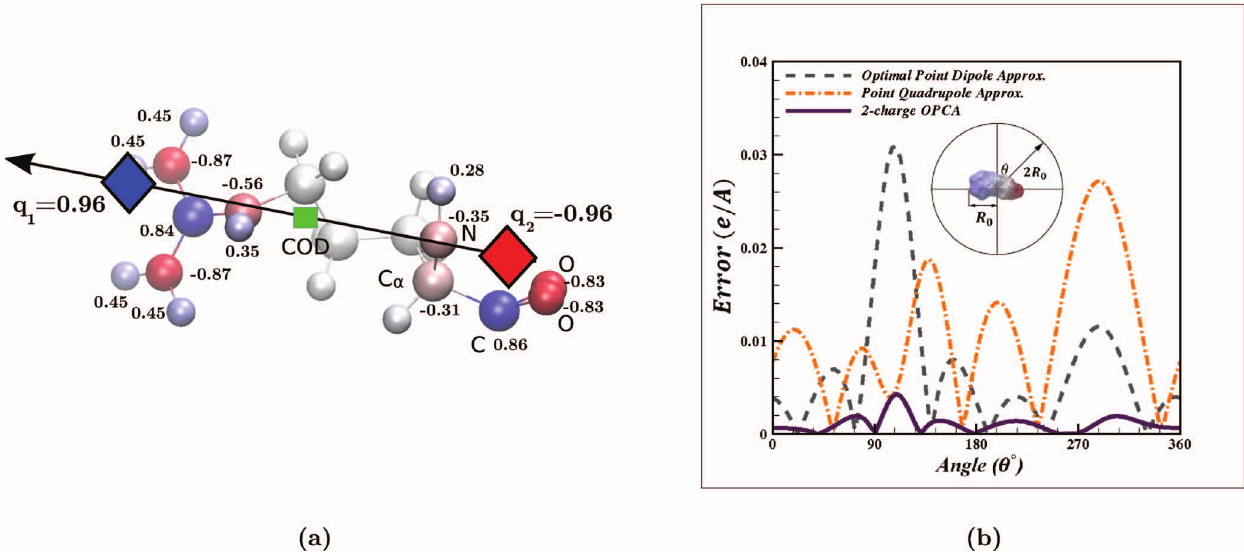
Figure 1. Example of a 2-charge optimal point charge approximation (OPCA). For a sample charge distribution–a neutral amino acid (C- terminal arginine at physiological pH), including the associated NH-CH-COO backbone atom. ( a ) The green square represents the center of dipole (COD), with dipole moment p shown by the arrow. The two diamonds represent the two point charges, q 1 and q 2 , of the OPCA. The atomic partial charges are represented as spheres rendered using VMD [21]. The sphere colors range from red to blue representing the charge range of { 1 e to z 1 e , where e is the atomic unit of charge. The charge values for partial charges D q D w 0 : 2 e are shown next to the atoms. As a visual reference, the backbone heavy atoms are labeled and covalent bonds are included in the figure. ( b ) Error in electrostatic potential for the 2-charge OPCA, point dipole, and point quadrupole with center of dipole as the expansion center. The error is calculated relative to the exact computation, on a circle at a distance 2 R 0 , in the plane shown. Here, R 0 is the size of the charge distribution defined as the distance from its center of geometry to the outermost charge. The inset image shows the electrostatic surface potential rendered using GEM [22]. doi:10.1371/journal.pone.0067715.g001 distributions relevant to biomolecular modeling, see the Results section below.